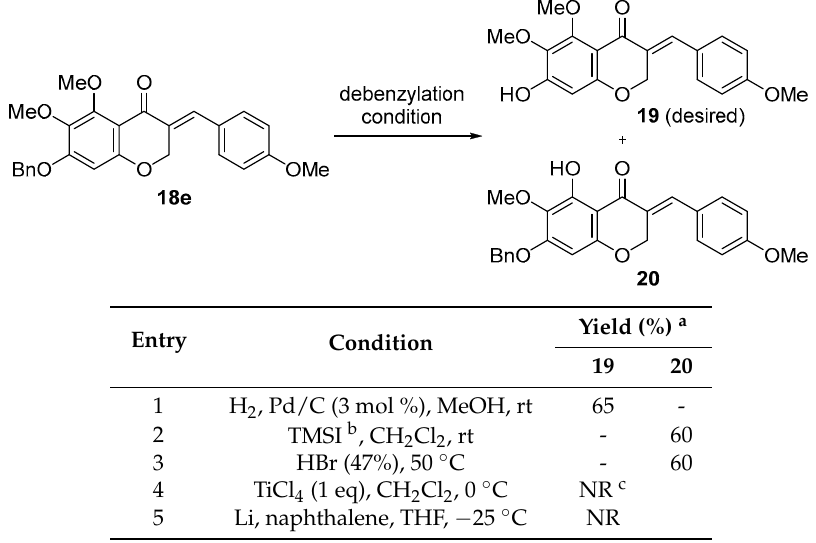
Table 2. C7-debenzylation conditions of 5,6,7-trisubstituted 3-benzylidene-4-chromanone ( 18e ).